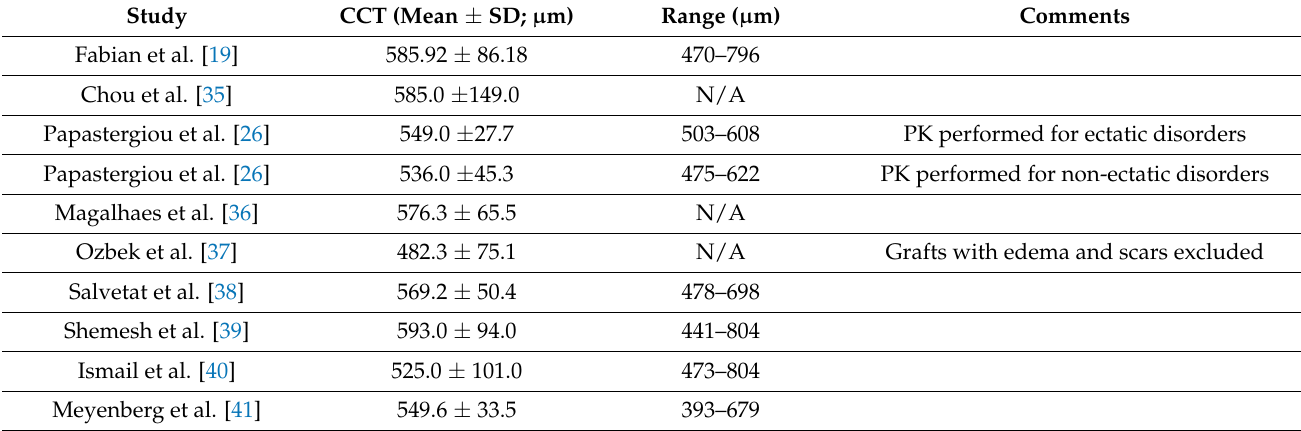
Table 1. Central corneal thickness after